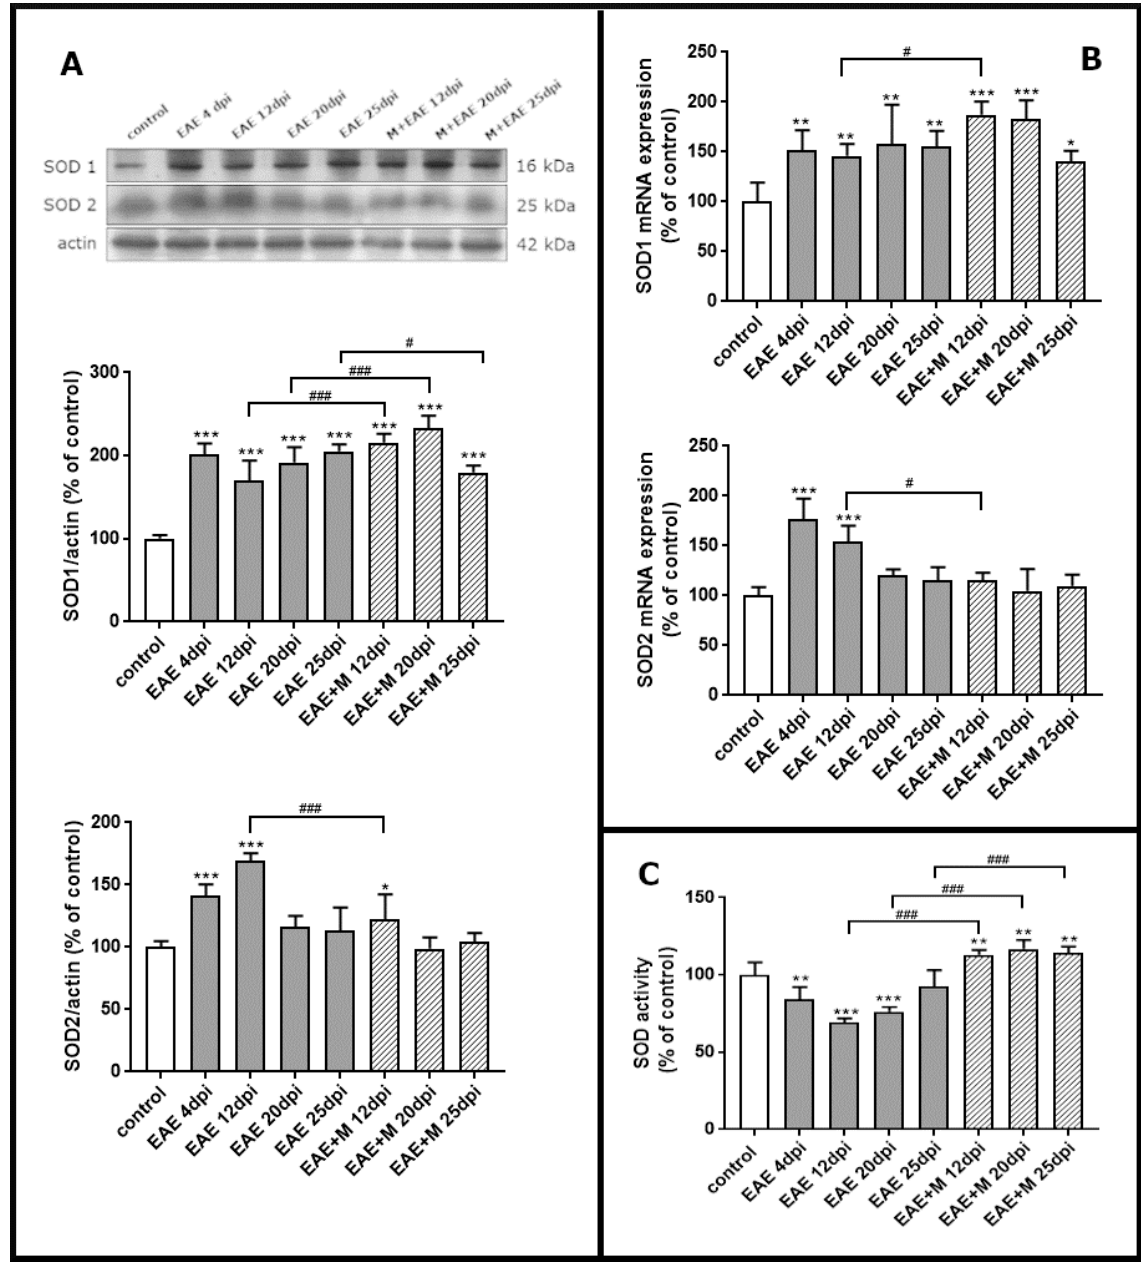
Figure 3. The expression of superoxide dismutases SOD1 and SOD2 in the brain of control and experimental autoimmune encephalomyelitis (EAE) rats at different times post-immunization and after therapeutic treatment with memantine. Representative immunoblots and bars showing the relative levels of enzymatic protein ( A ), bars showing the expression of enzymatic mRNA ( B ), and bars showing the total activity of SODs enzymes ( C ). The results are the means from n = 4 animals in each group and are expressed as a percentage of control. * p < 0.05; ** p < 0.01; *** p < 0.001 significantly different vs. control rats; # p < 0.05, ### p < 0.01 significantly different vs. EAE rats not subjected to therapy. (one-way ANOVA followed by Bonferroni’s multiple comparison